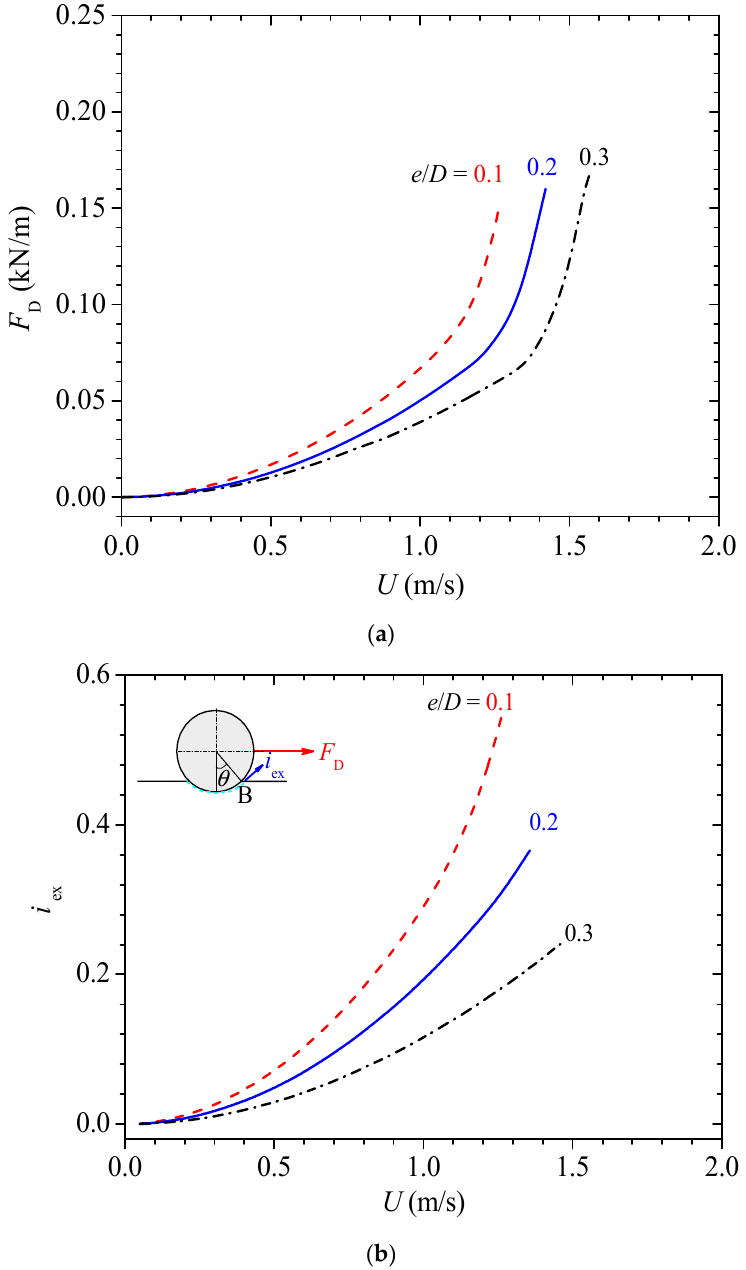
Figure 11. Variations of ( a ) the drag force on the pipe ( F D ) and ( b ) the hydraulic gradient at the seepage exit ( i ex ) with the flow velocity ( U ) for various values of e/D .